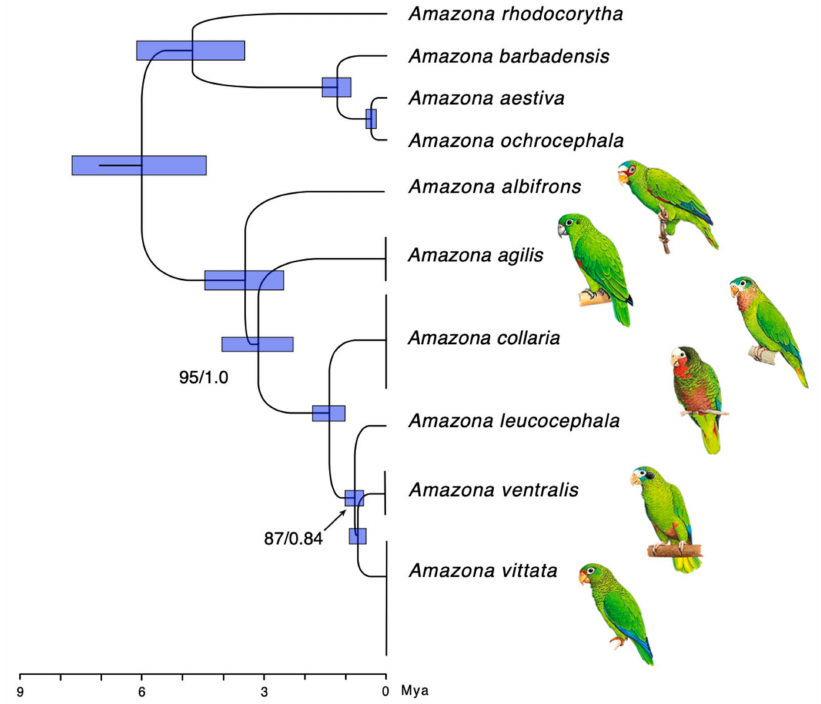
Figure 2. Fragment of the time tree for the Greater Antillean amazon parrots based on Bayesian inference in the larger context of Neotropical parrot evolution. The complete phylogeny is shown in Supplementary Figures S5 and S6. All nodes except the ones indicated with numbers received both maximum likelihood bootstrap (100%, based on 1000 pseudo- replicates) and Bayesian posterior probability (1.0) support. The timescale is in millions of years ago (MYA). The tree was rooted with mitogenomic sequences of macaws and parakeets (all sources listed in Supplementary Table S4). The Bayesian analysis with a relaxed clock model rendered the same tree topology with nearly identical node ages and support values (see Supplementary Figure S6). The maximum likelihood and maximum parsimony trees (Supplementary Figures S2 and S3) are congruent with the tree